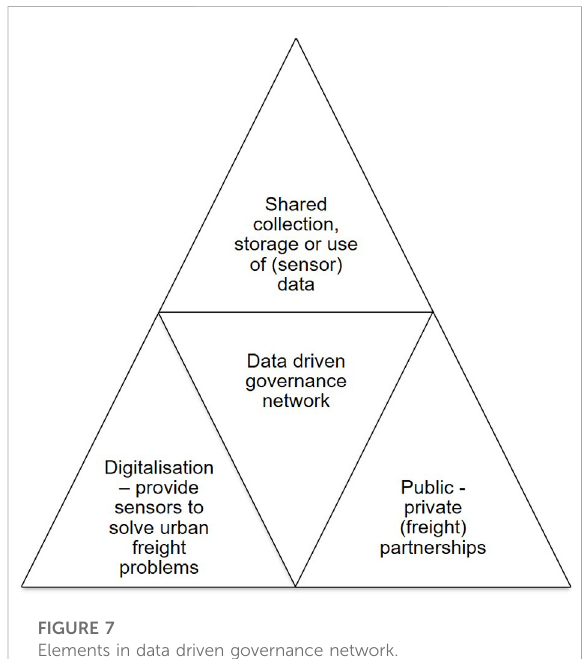
FIGURE 7 Elements in data driven governance